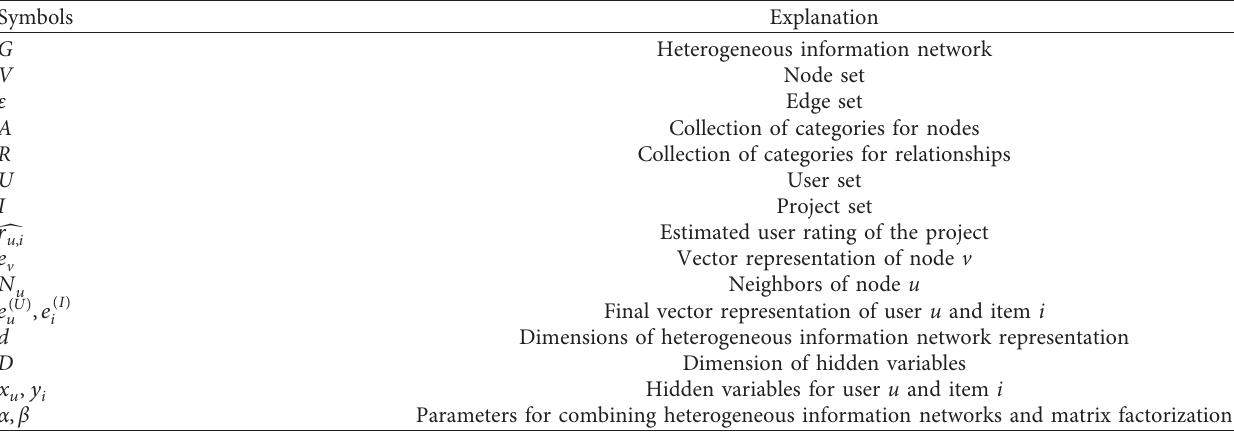
Table 1: Related notations and explanations.